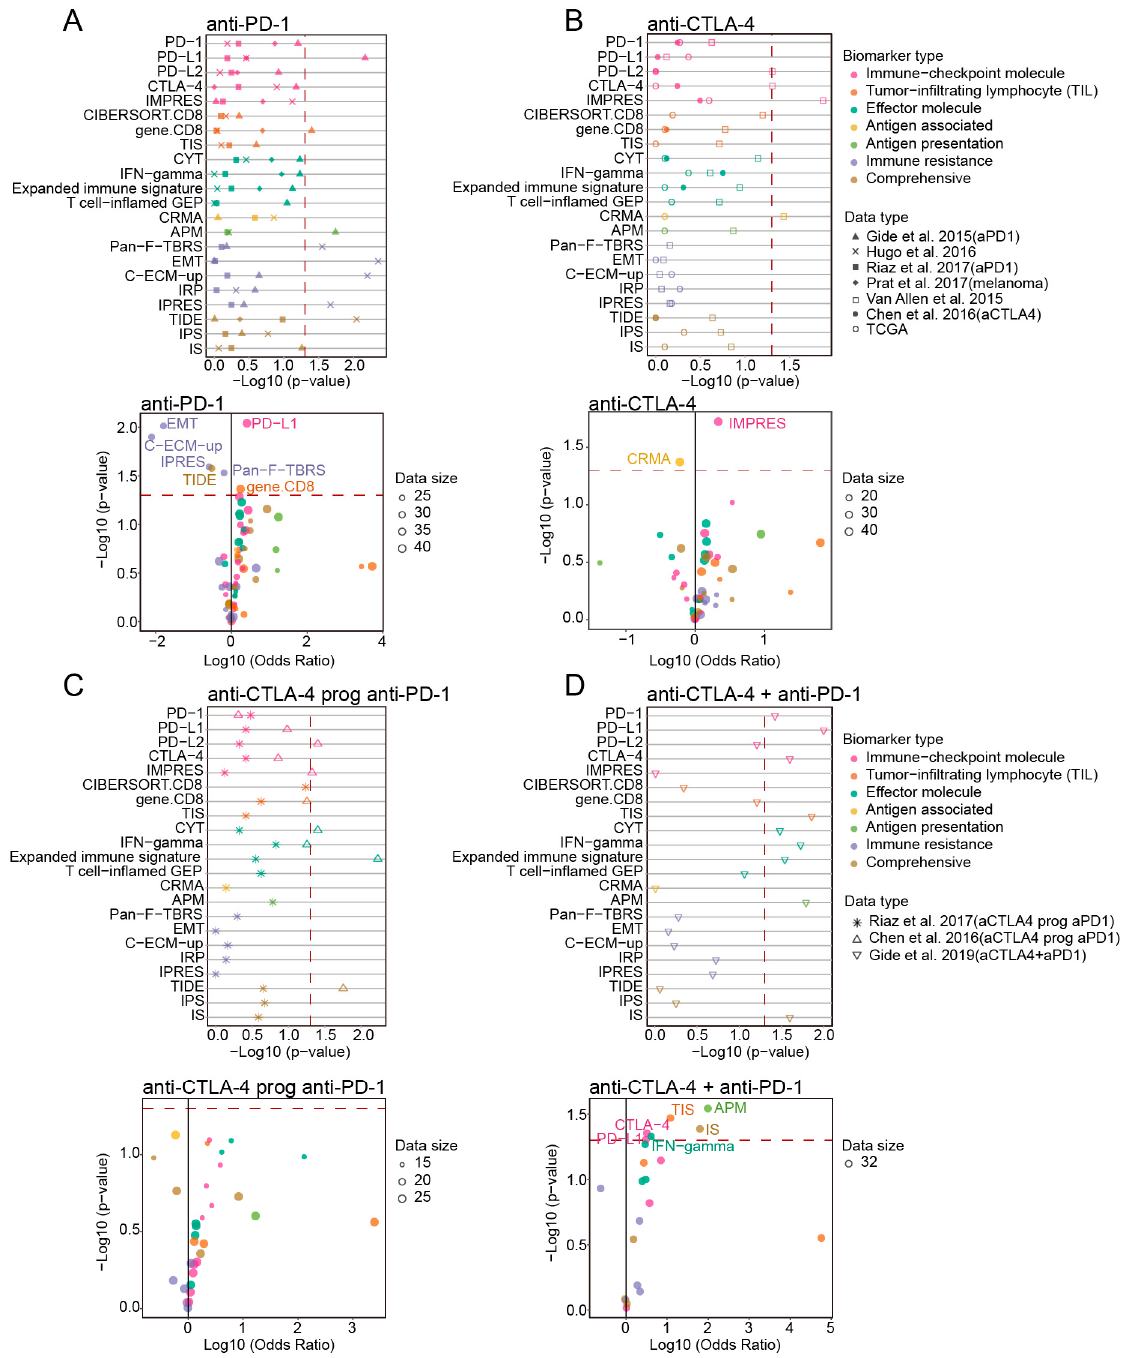
Figure 4. Correlation of biomarkers with clinical response to ICB across multiple datasets with different ICB therapy strategies. ( A – D ) Top: the two-sided Wilcoxon rank-sum test p value indicating whether biomarkers significantly differentiate between responders (R) versus non-responders (NR) (patients stratification using “PD” strategy) in four ICB therapy strategies, red dashed line indicated 0.05 threshold of p value. Bottom: scatterplot showed log10 (Odds Ratio) and − log10 ( p -value) from univariate logistic regression model for different ICB therapies. Red dashed line indicated 0.05 threshold of p value.